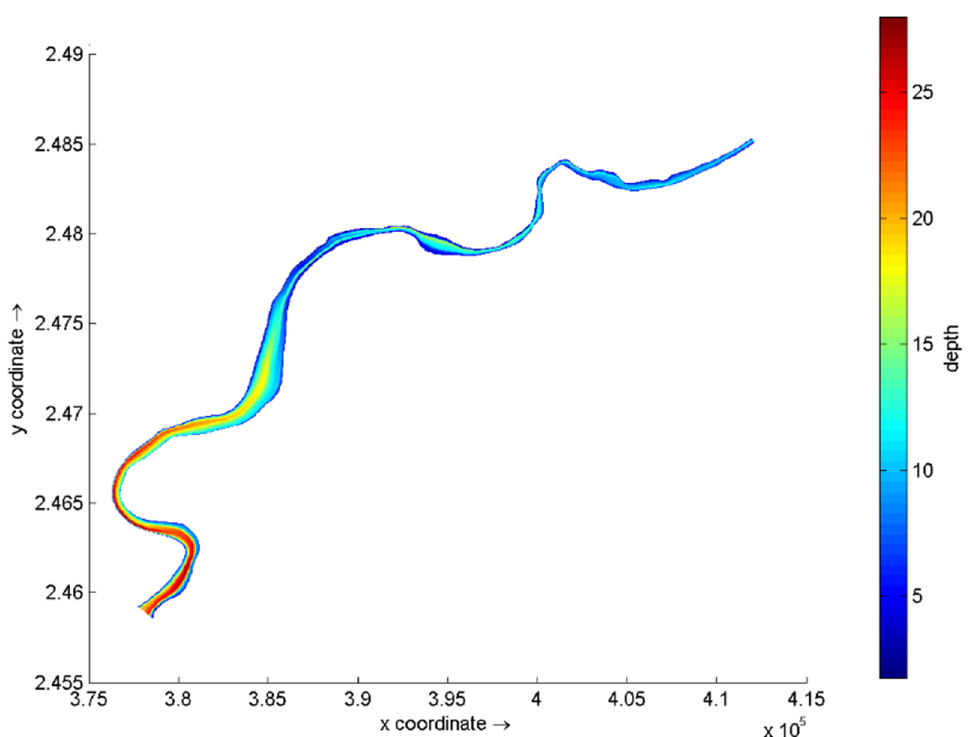
Figure 4. Bathymetry map of the study area.